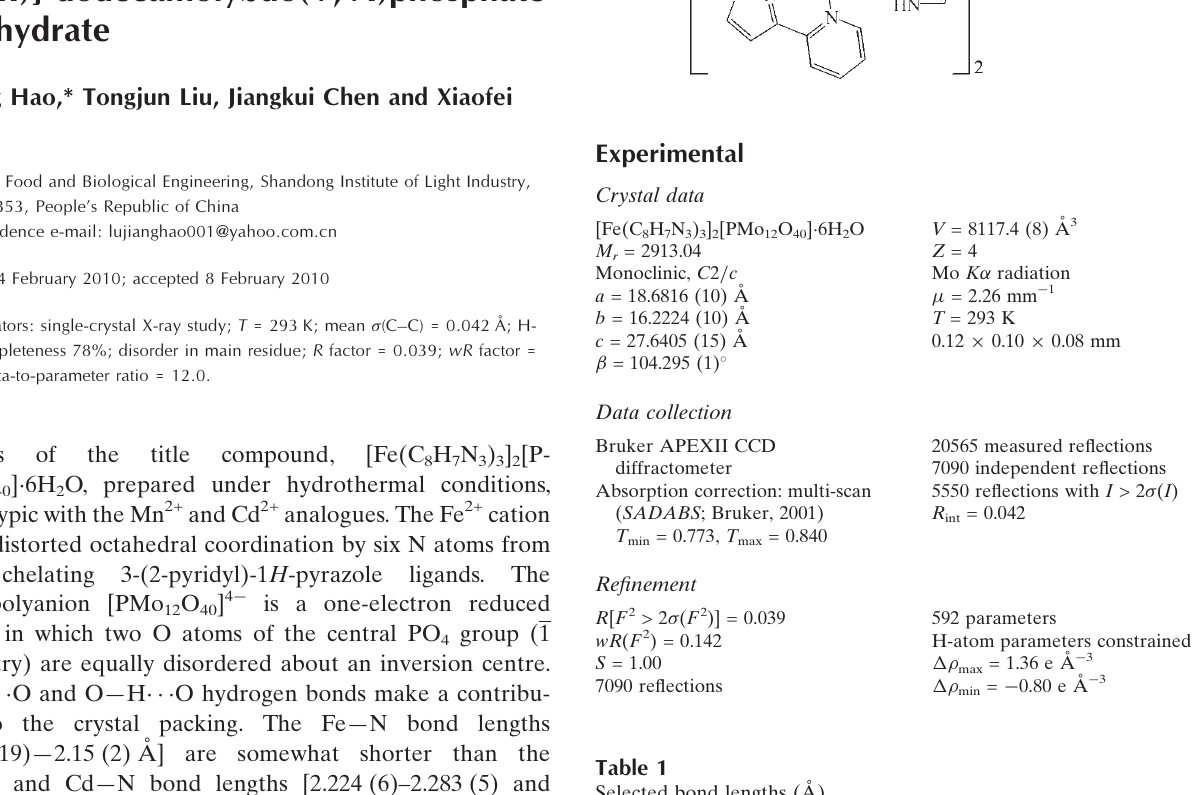
Selected bond lengths (A˚ ).